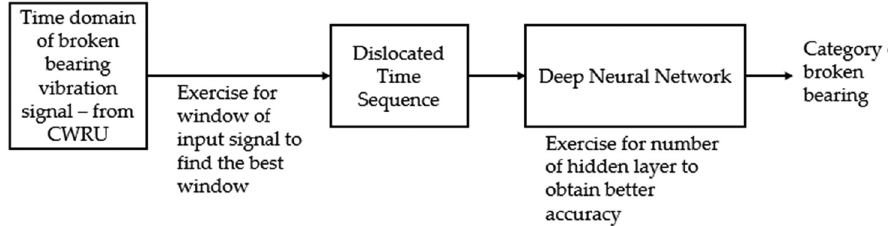
Figure 3: Whole idea of the work done in this study.